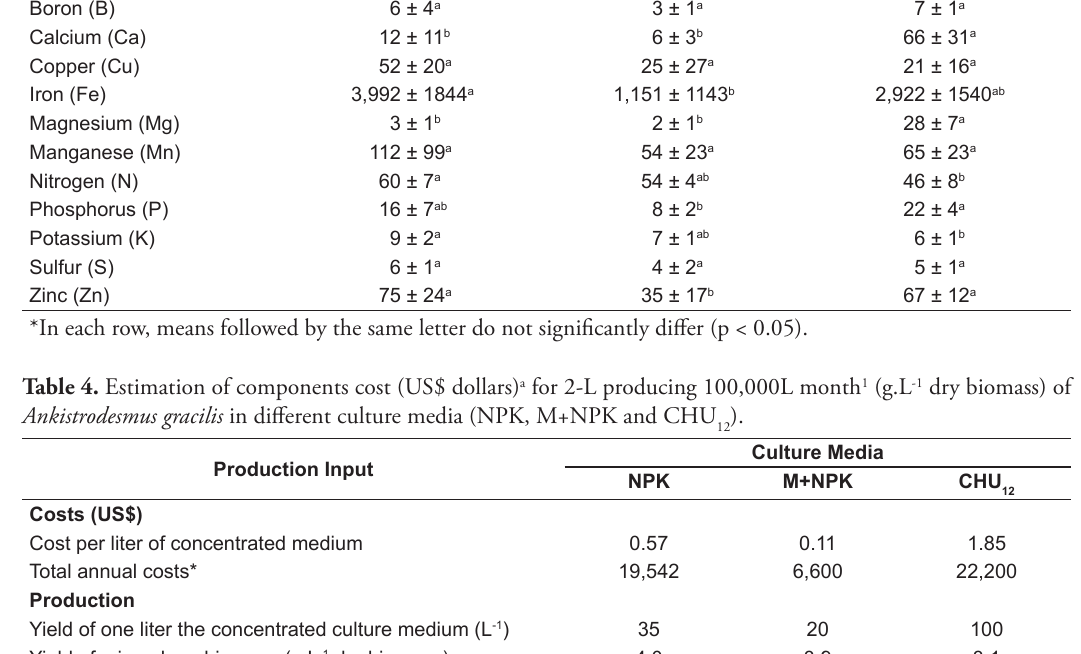
Table 3. Values obtained for macronutrients and micronutrients (g.L -1 ) of Ankistrodesmus gracilis biomass in inorganic fertilizer (NPK), macrophyte with inorganic fertilizer (M+NPK) and commercial medium (CHU mean ± SD* of three replicates per medium (NPK, M+NPK and CHU Nutrient Composition